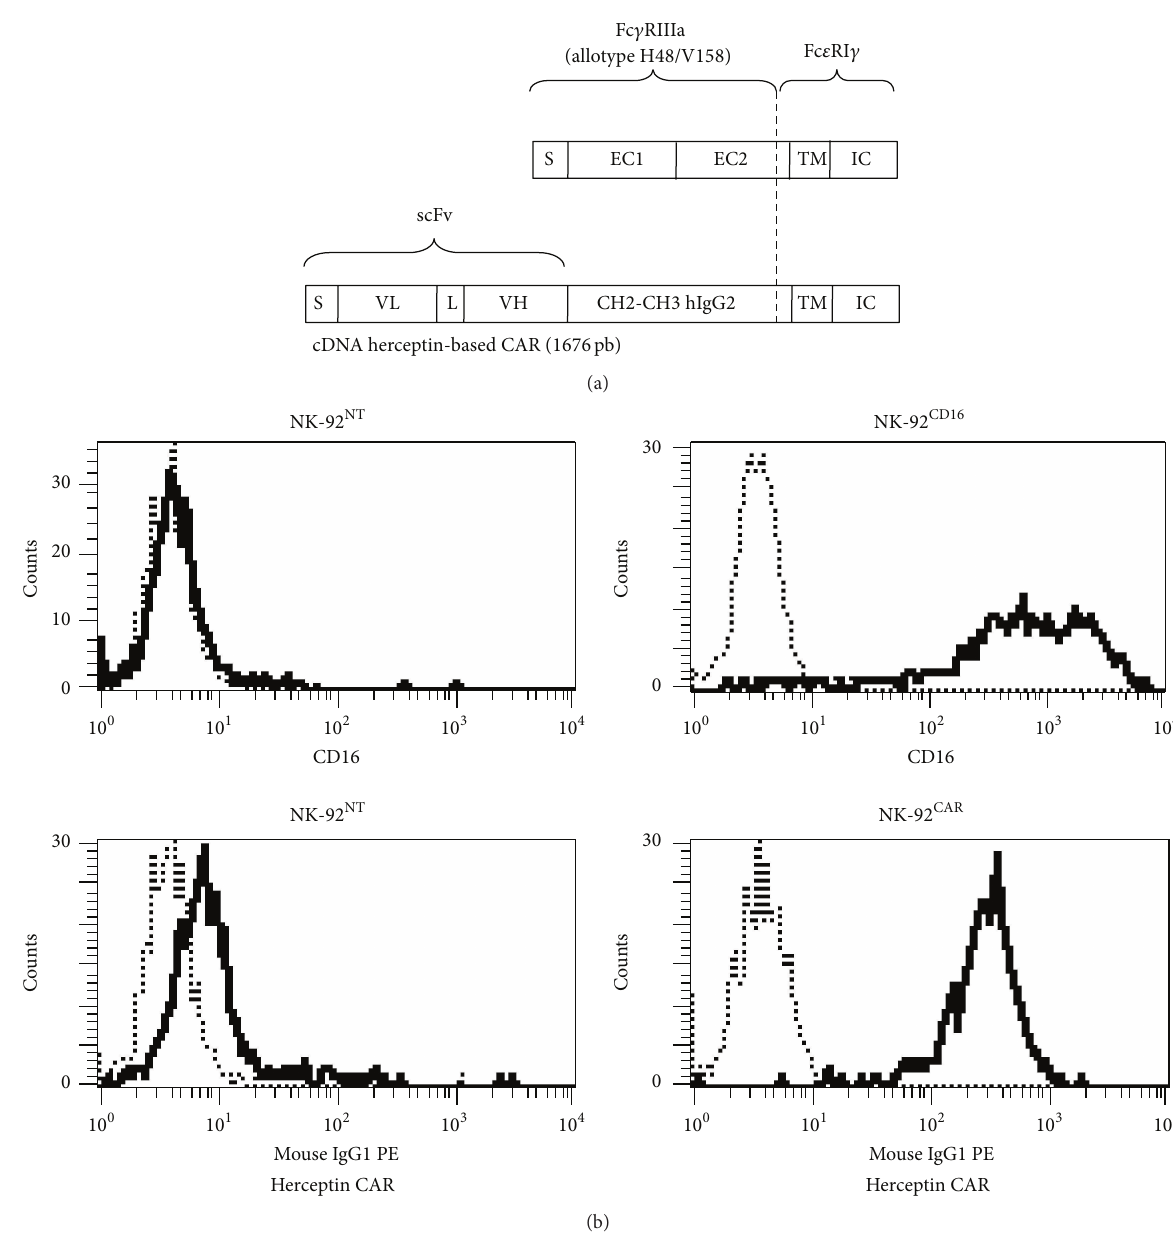
Figure 1: CD16 and CAR vector design and expression in NK-92 cells. (a) Schematic representation of the chimeric human Fc 𝛾 RIII-human Fc 𝜀 RI 𝛾 molecule and the trastuzumab- (4D5-) based CAR against HER2: the CD16/ 𝛾 chimeric cDNA comprised the leader (S) and the two extracellular domains (EC1 and EC2) of human CD 16 H 48 V 158 , two amino acids (aa) of the extracellular domain of human Fc 𝜀 RI 𝛾 , and the intact transmembrane (TM) and intracellular (IC) domains. The trastuzumab- (4D5-) based CAR contains the VL: hum Ab 4D5-8 light chain; a linker; VH: hum Ab 4D5-8 heavy chain and two amino acids (aa) of the extracellular domain of the human Fc 𝜀 RI 𝛾 ; and the intact transmembrane (TM) and intracellular (IC) domains. (b) Transgene expression of NK-92 cell line transduced with CD16- 𝛾 chimeric receptor or trastuzumab- 𝛾 CAR. Anti-CD16 (clone 3G8) was used to determine CD16 expression on CD16- 𝛾 transduced NK-92 cell line (solid line), and an isotype Ab was used as negative control (dotted line). Anti-human IgG2a-Fc (clone HP6002) was used to determine trastuzumab- 𝛾 CAR expression on trastuzumab- 𝛾 CAR transduced NK-92 cell line (solid line), and an isotype Ab was used as negative control (dotted